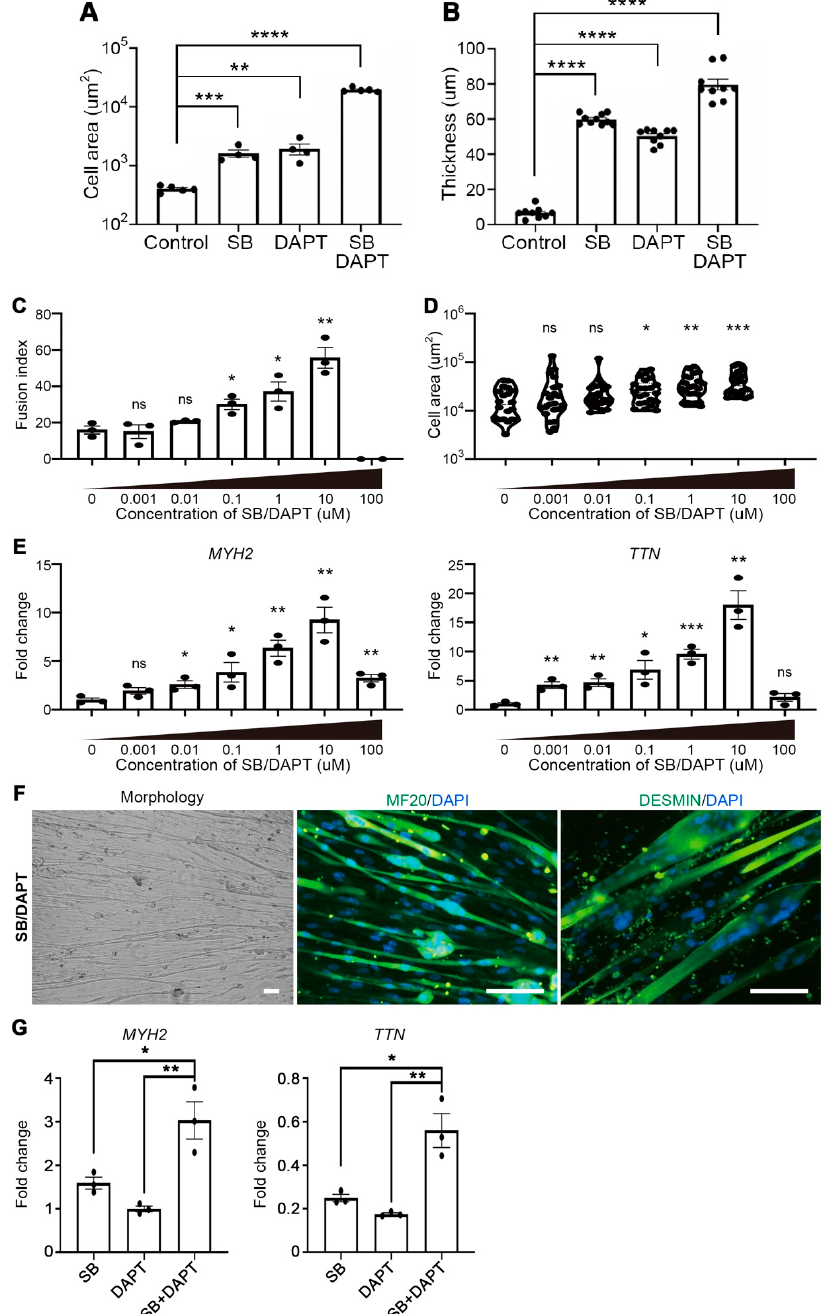
Figure 3. Augmentation of myotube formation and fusion ability by combinatorial treatment of SB-431542 and DAPT. ( A ) Quantification of cell area of myotubes following single or combinational treatment of SB-431542 and DAPT. ( B ) Quantification of the thickness of myotubes with SB-431542, DAPT, or combinational treatment. ( C ) Quantification of myotube for fusion index in dose-dependent combinational treatment of two small molecules. ( D ) The area of individual myotubes stained with MF20 in dose-dependent combinational treatment of two small molecules. ( E ) Fold changes of expression levels with myotube-specific marker genes, MYH2 and TTN in dose-dependent combinational treatment of two small molecules. ( F ) Representative image of myotube differentiated with SB-431542 and DAPT (10 µM each) and immunofluorescence staining image of stained myotube with an antibody against MF20 and DESMIN with SB-431542 and DAPT (10 µM each). ( G ) Relative mRNA expression levels of myotube marker genes in single SB treatment, single DAPT treatment, and combinational SB+DAPT treatment. Scale bars = 100 um. * p < 0.05, ** p < 0.01, *** p < 0.001, **** p < 0.0001, ns = non significance, One-way ANOVA.